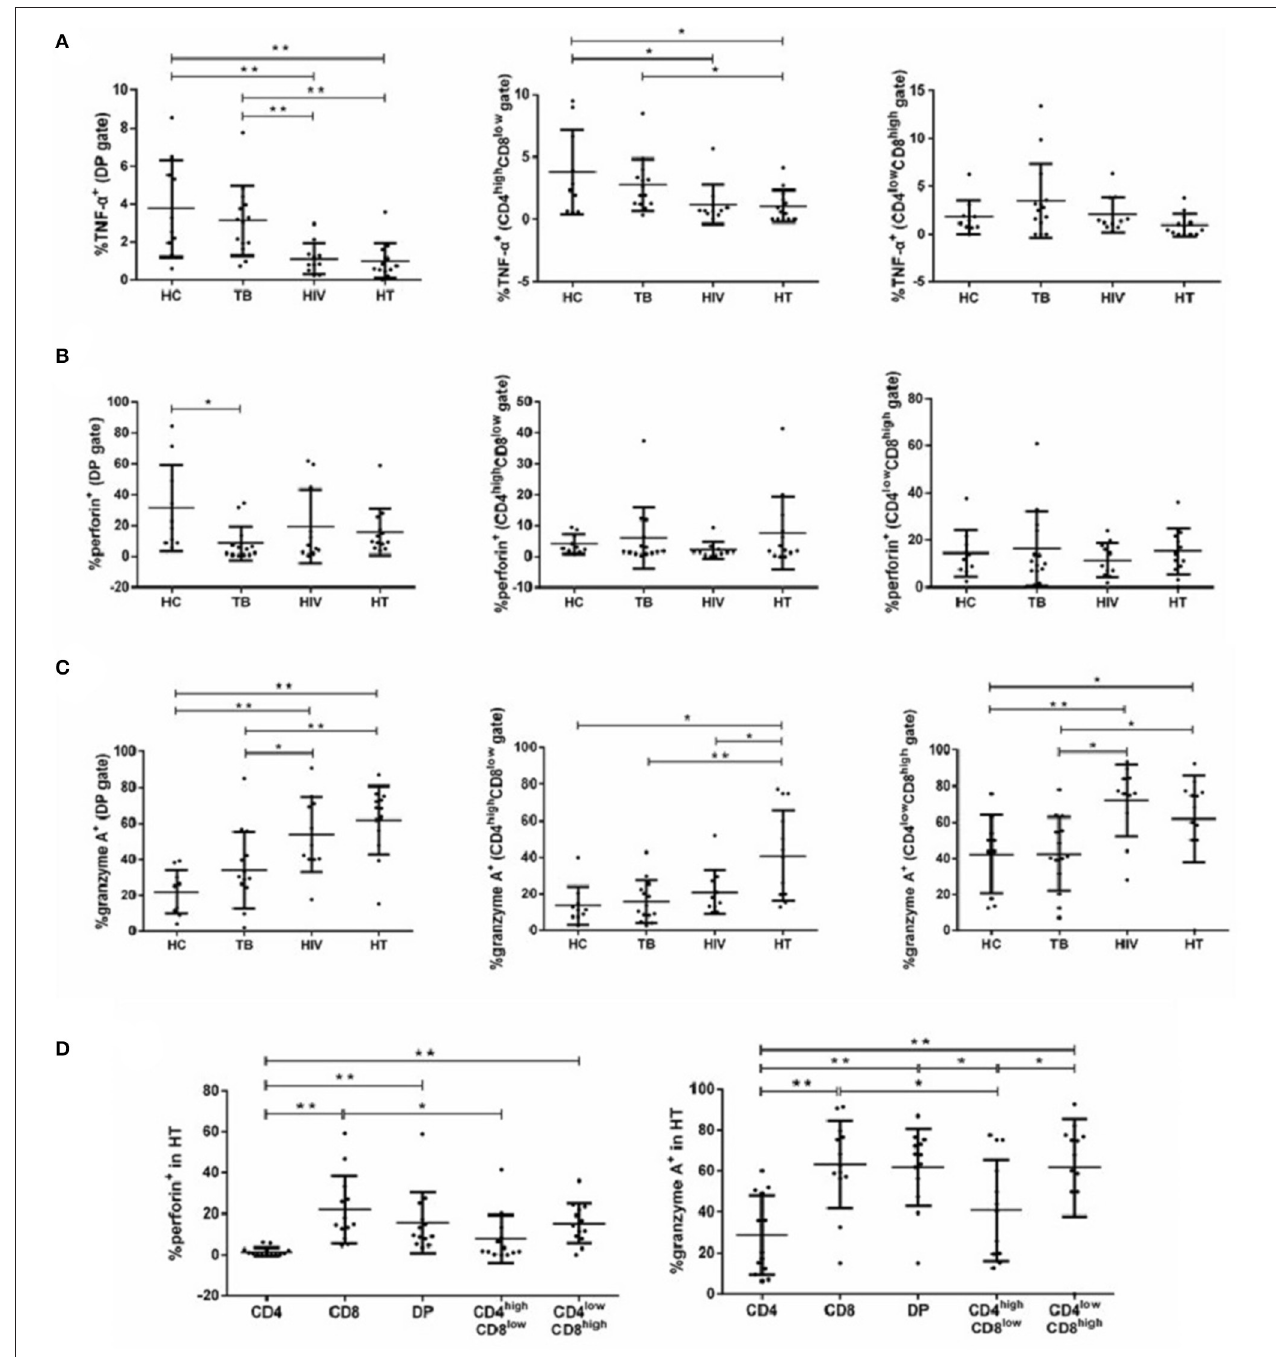
FIGURE 4 | Function of DP T cells among each group. Percentages of DP T subsets producing TNF- α (A) , perforin (B) , and granzyme A (C) in each group are shown. Subjects that produce cytokines of perforin and granzyme A in T-lymphocyte subsets among the HT group are shown in (D) . P -value calculated using the Mann–Whitney U test. Statistically significant differences between the groups are indicated as follows: * p < 0.05 and ** p < 0.01.